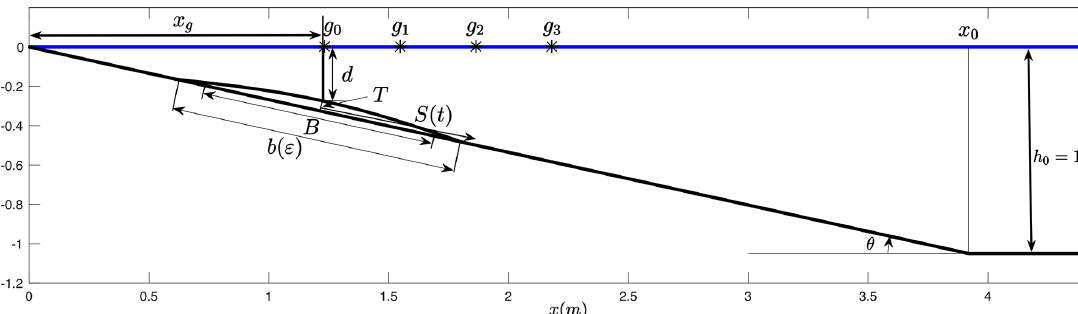
Figure 3. BP1. Sketch of main parameters and variables for wave generation by 2D rigid slide (modified from Grilli and Watts, 2005).